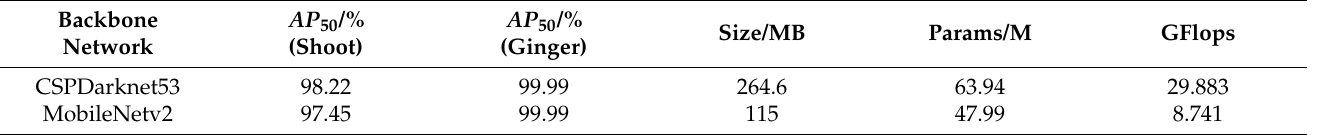
Table 4. Experimental results under different feature extraction